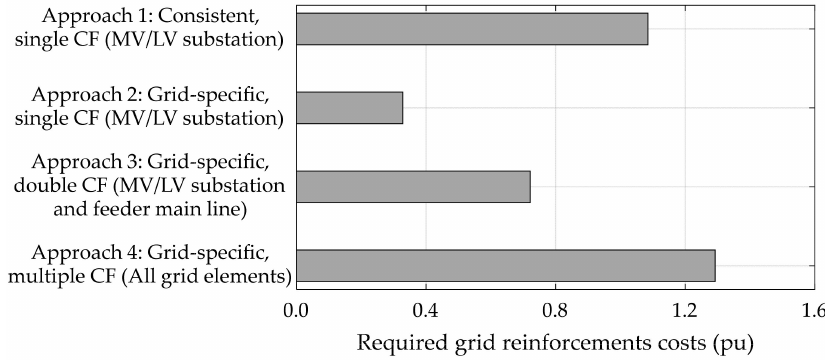
Figure 10. Comparison of different approaches to applying coincidence factors (CF) regarding the required grid reinforcement costs (7114 LV grids